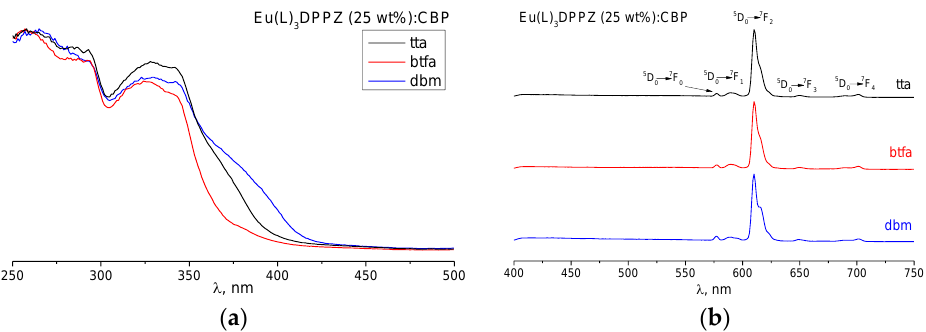
Figure 3. ( a ) Excitation and ( b ) photoluminescence spectra of Eu(dik) 3 DPPZ thin films doped into CBP: Eu(dik) 3 DPPZ, dik = dbm (blue), btfa (red), and tta (black). CBP: Eu(dik) 3 DPPZ, dik = dbm (blue), btfa (red), and tta T he PLQY and observed lifetime (τ obs ) values strongly depend on the host. This